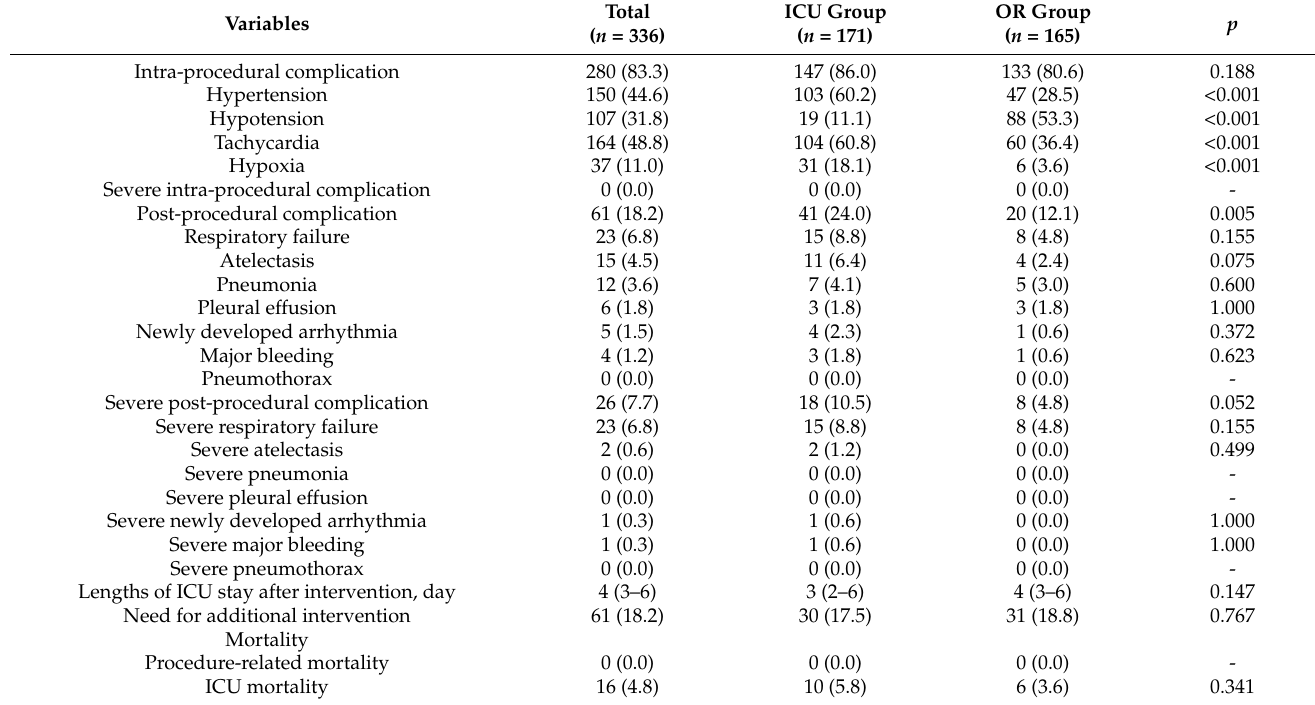
Table 3. Clinical